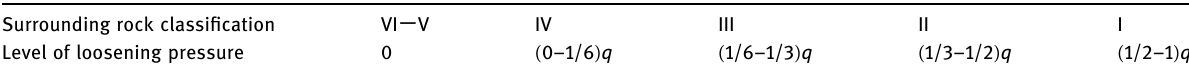
Table 1: Lateral horizontal loosening pressure